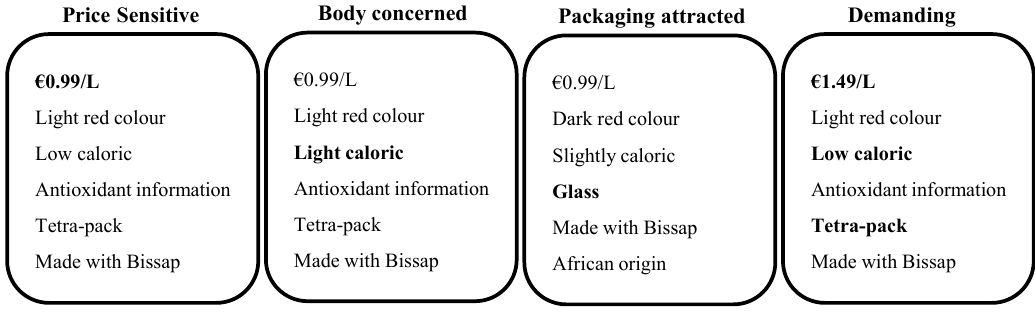
Table 9. Characterization of the participants assigned to each cluster identified in the conjoint study (in percentage).